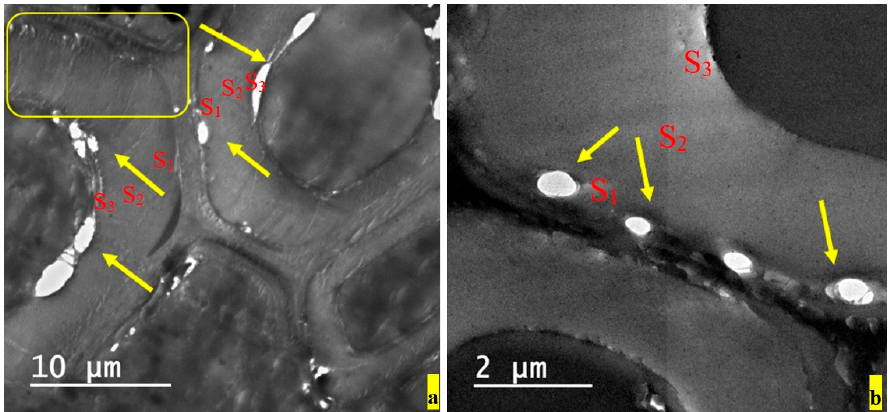
Figure 6. TEM photos ( a , b ) of wood samples infected with T. harzianum, showing cavities within the S 3 and S 1 layers, similar to soft-rot decay type I, and erosion within S 3 (soft-rot decay type II). In addition, checks can be seen within the S 2 layer.